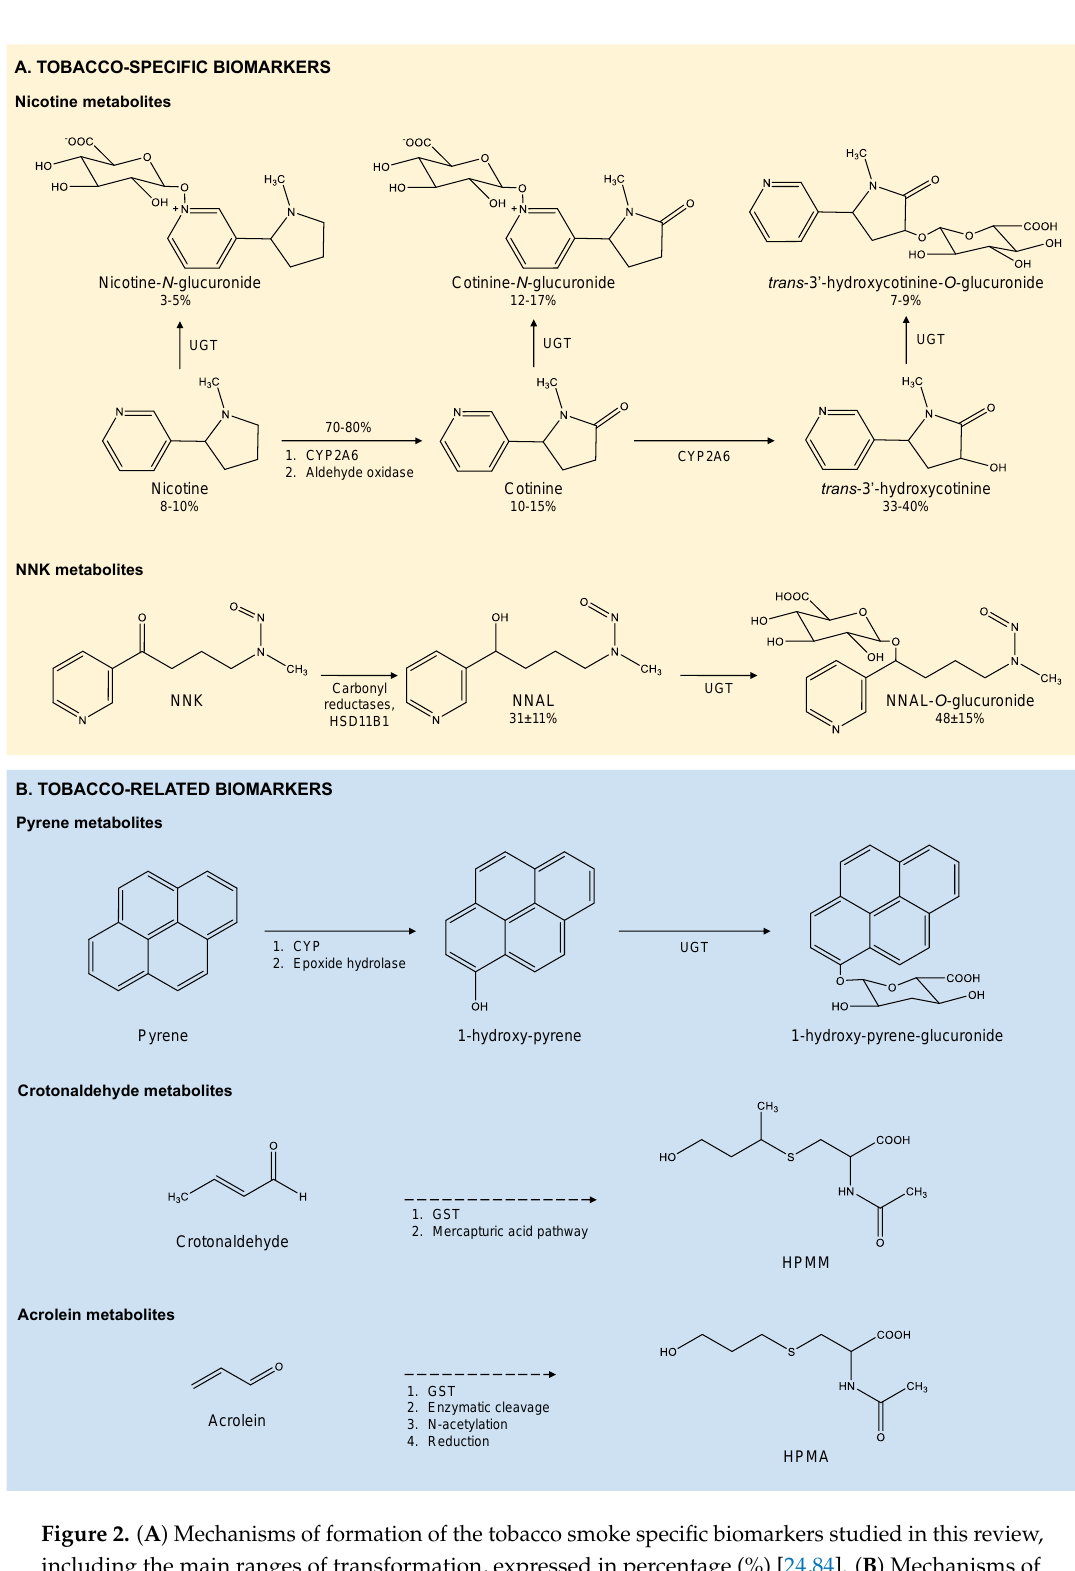
Figure 2. ( A ) Mechanisms of formation of the tobacco smoke specific biomarkers studied in this review, including the main ranges of transformation, expressed in percentage (%) [24,84]. ( B ) Mechanisms of formation of some tobacco smoke-related biomarkers reviewed here [85–87].